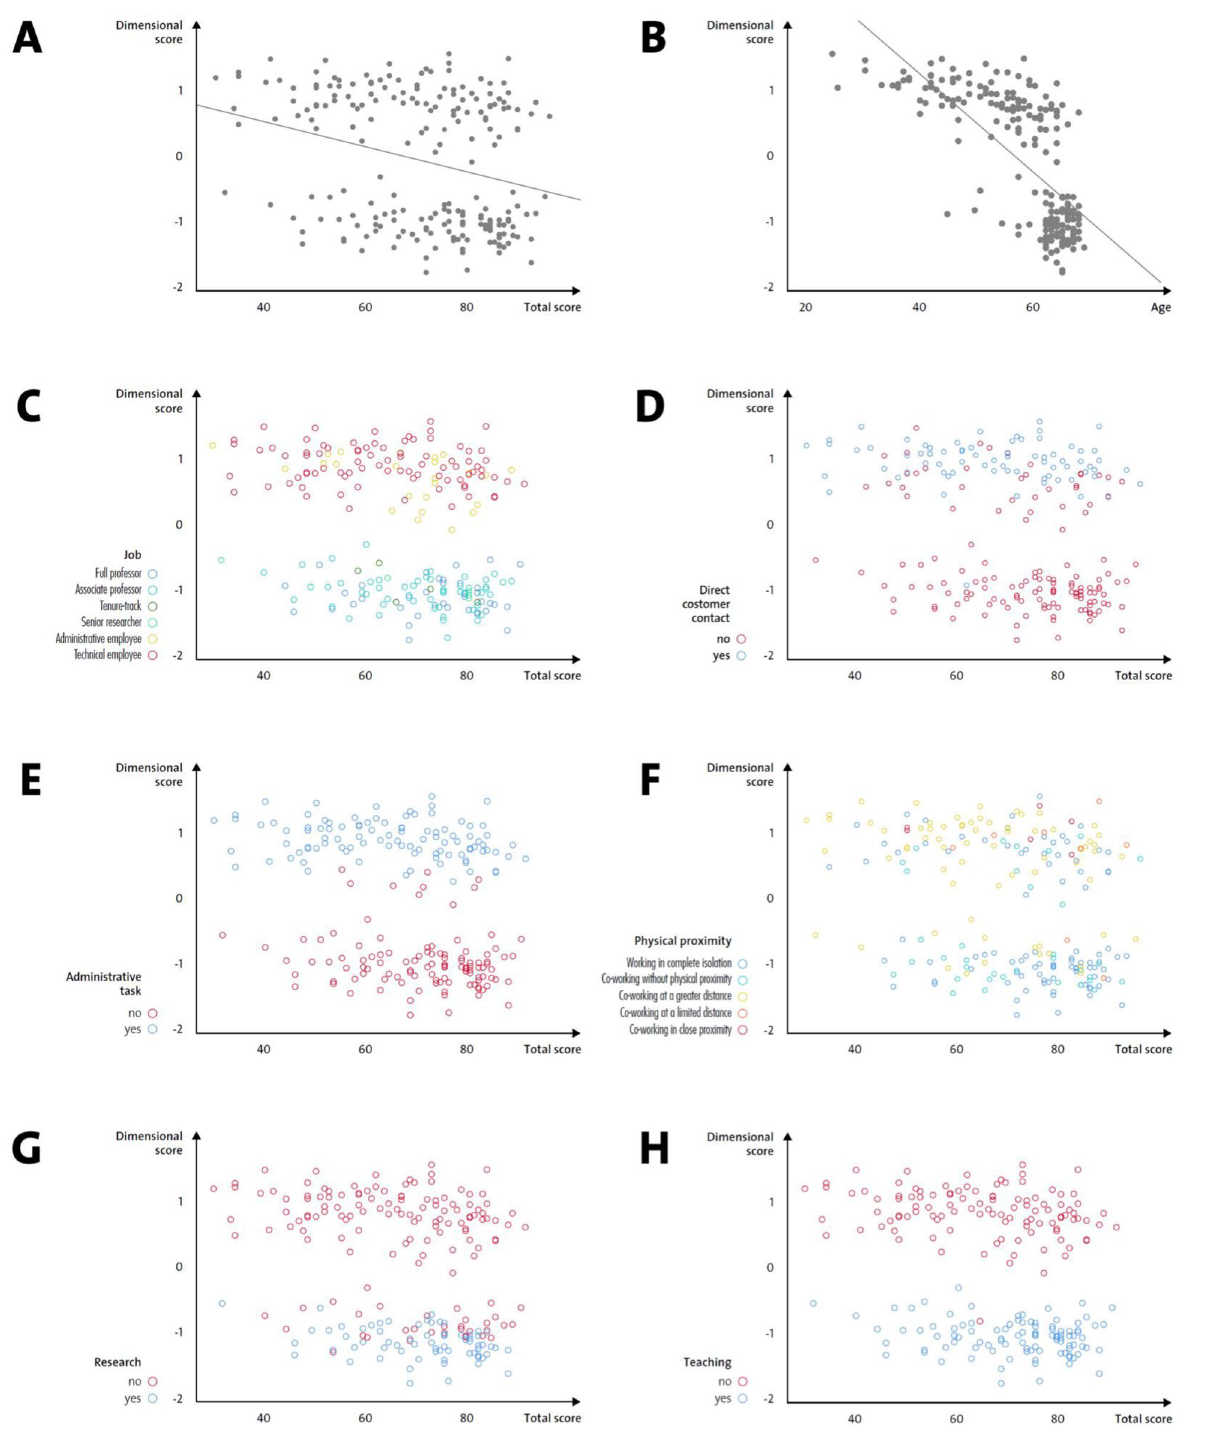
Figure 1. ( A ) Regression analysis between the first component (dimensional score) and the dependent variable total well-being scores. ( B ) Regression analysis between the first component (dimensional score) and age, the only linear independent variable contributing to the first component. ( C – H ) Relationship between the independent variables (job, direct contact, administrative task, physical proximity, research and teaching activity) identified by the PTCA as contributing to the first dimension and the dependent variable total well- being